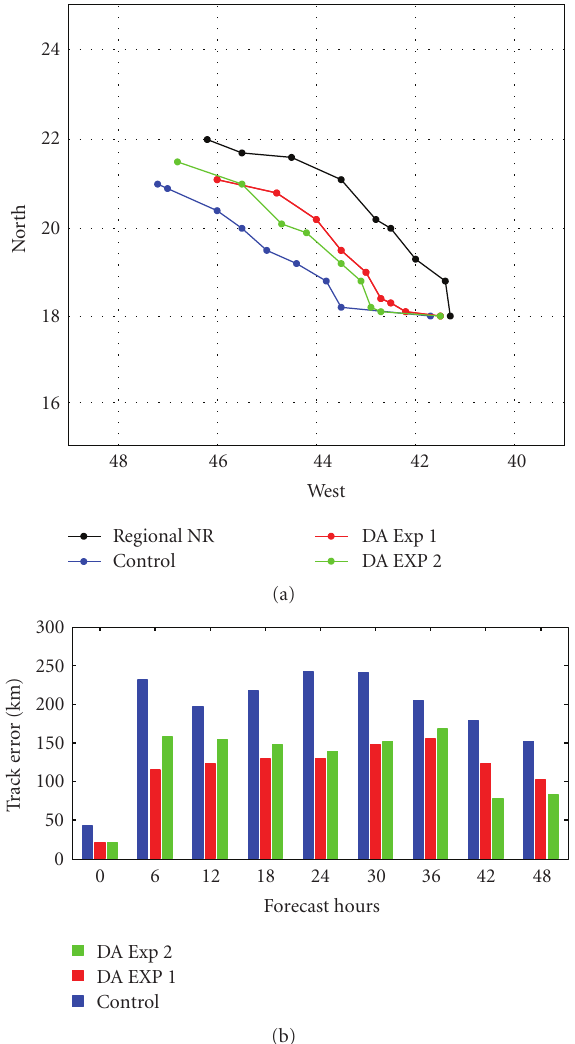
Figure 6: Time series of the tropical cyclone (a) track and (b) track error during 48-hour simulations for di ff erent experiments (black line: regional nature run; blue line: control run; red line: data assimilation Experiment 1; green line: data assimilation Experiment 2) from 0600UTC 01 to 0600 UTC 03 October